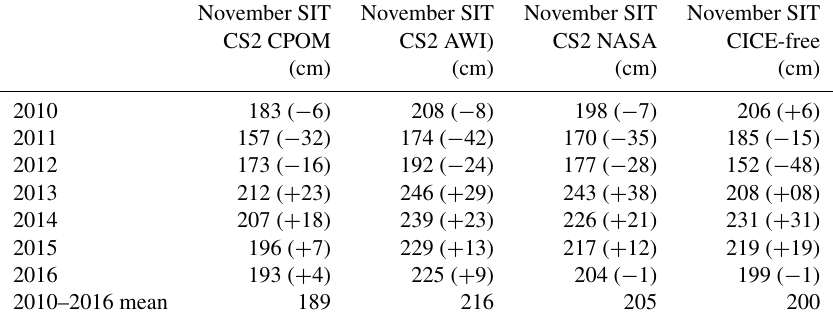
Table 2. Mean November ice thickness and anomaly with respect to the 2011–2017 mean (in parentheses) from CS2 derived from CPOM, AWI and NASA. Spatial mean is over the Arctic Basin, defined as the area for which CS-data were available continuously for all seven winter periods November to April 2010/2011 to 2016/17. This region corresponds to all three regions shown in Fig.